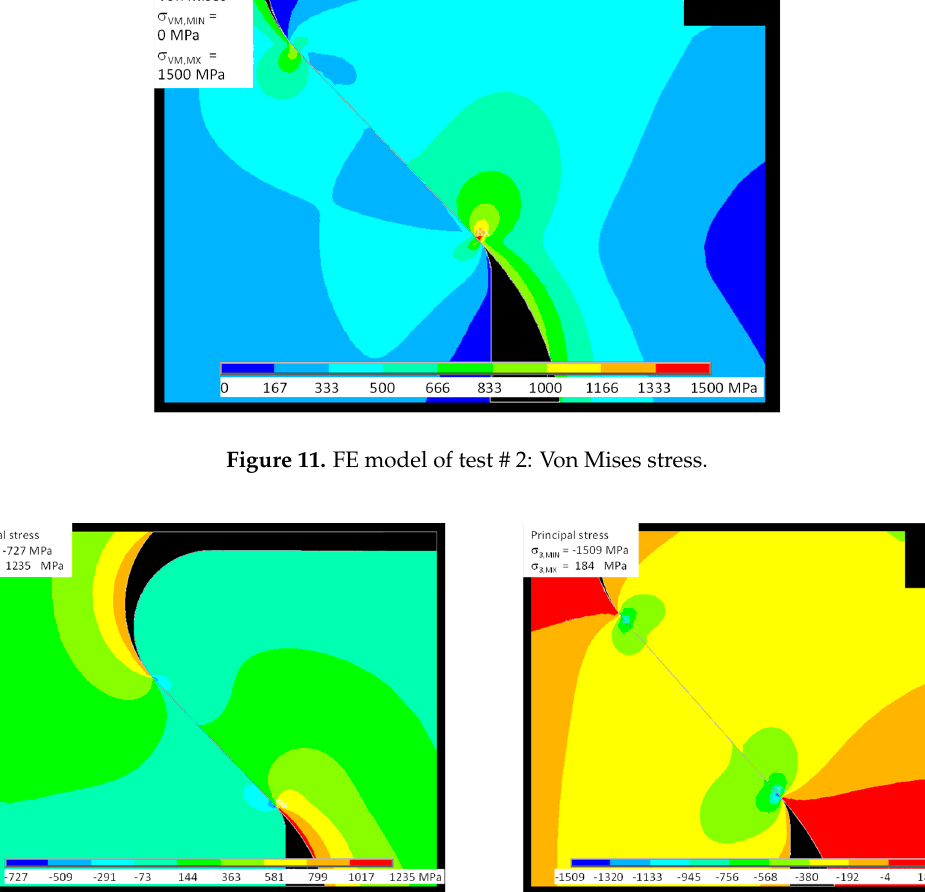
Figure 12. FE model of test # 2: ( a ) principal stress σ 1 ; ( b ) principal stress σ 3 .